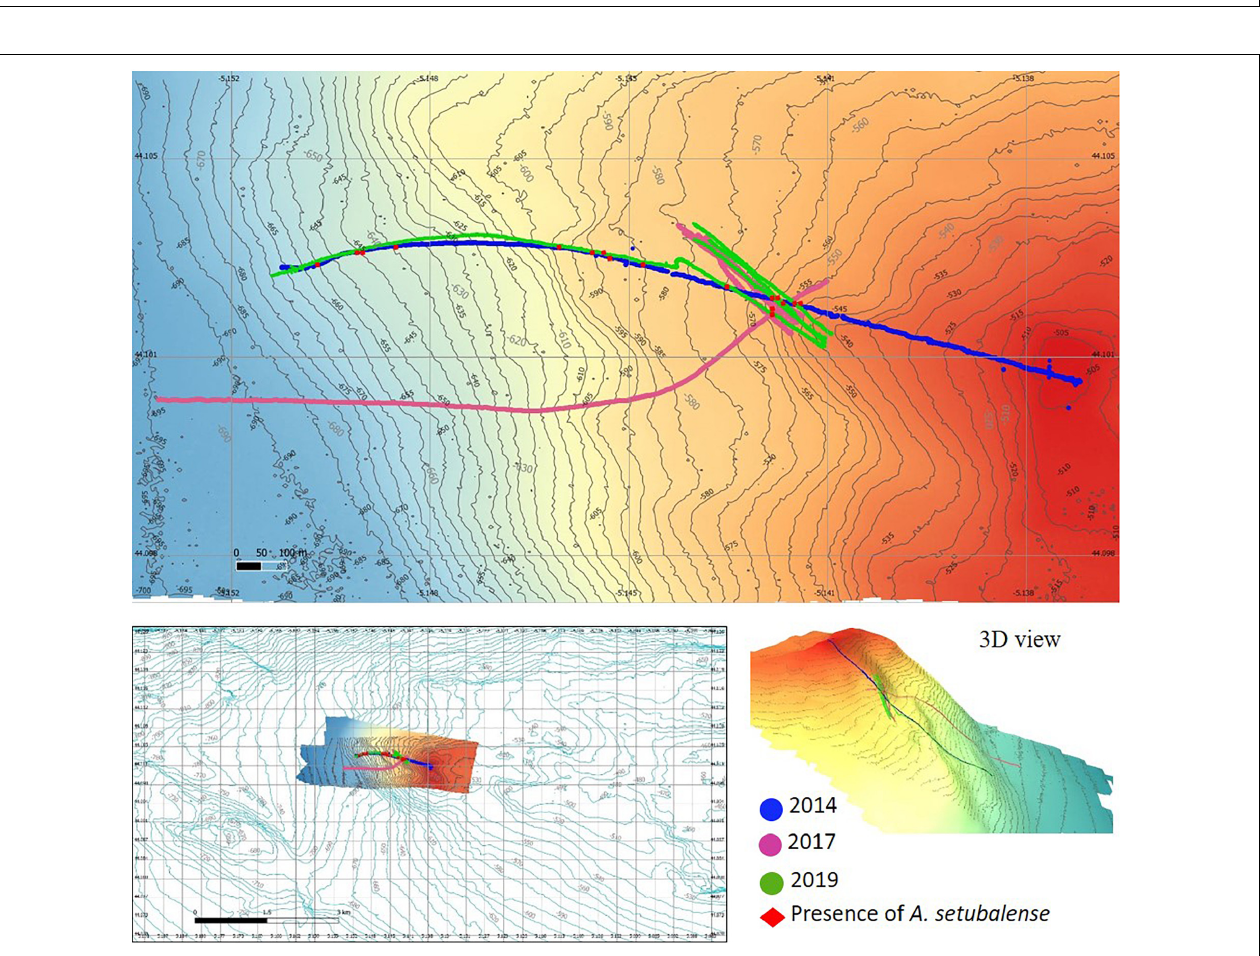
FIGURE 2 | Study zone 1: bathymetric characteristics, temporal image sampling series and presence of A. setubalense specimens.